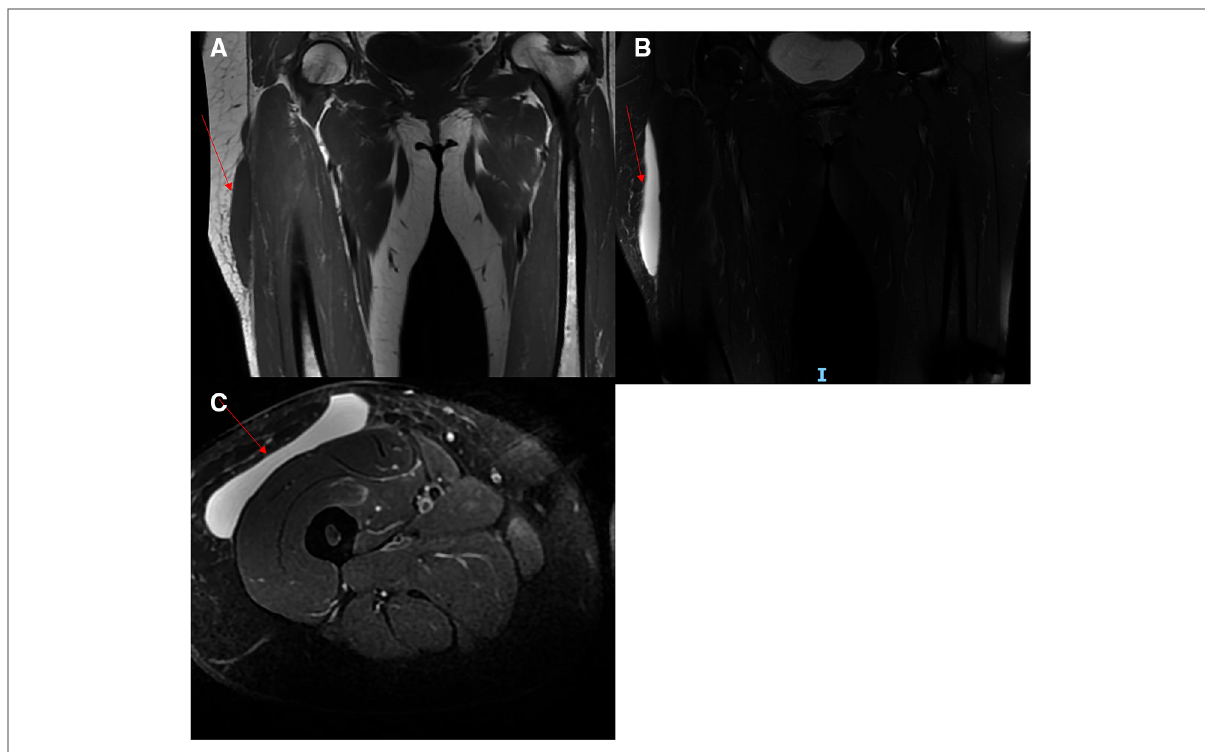
FIGURE 2 Magnetic resonance imaging of an MLL. ( A ): An abnormal signal intensity was observed in the subcutaneous tissue and the fascia lata of the anterolateral right thigh, which was hypointense on T 1 WI (red arrow). ( B and C ) The lesion was hyperintense on T 2 WI (red arrow).